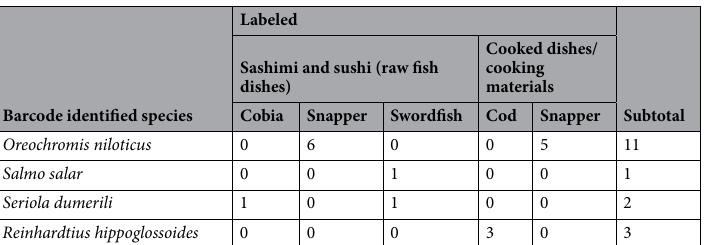
Table 1. Mislabel events tabulated by barcode-identified fish species and product labels (not counting surimi products).